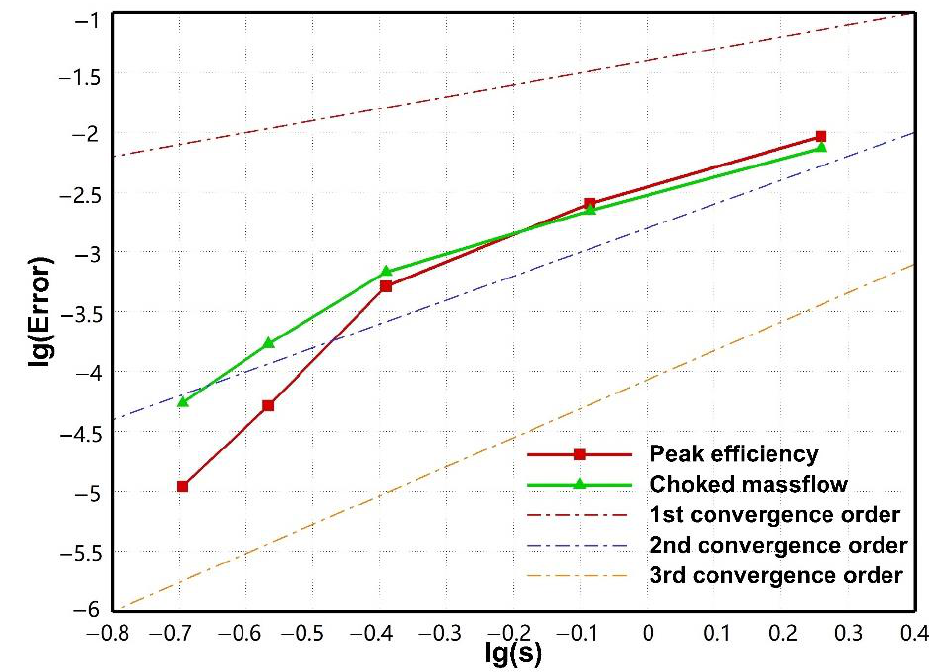
Figure 9. Log-log plot of the error convergence lines.